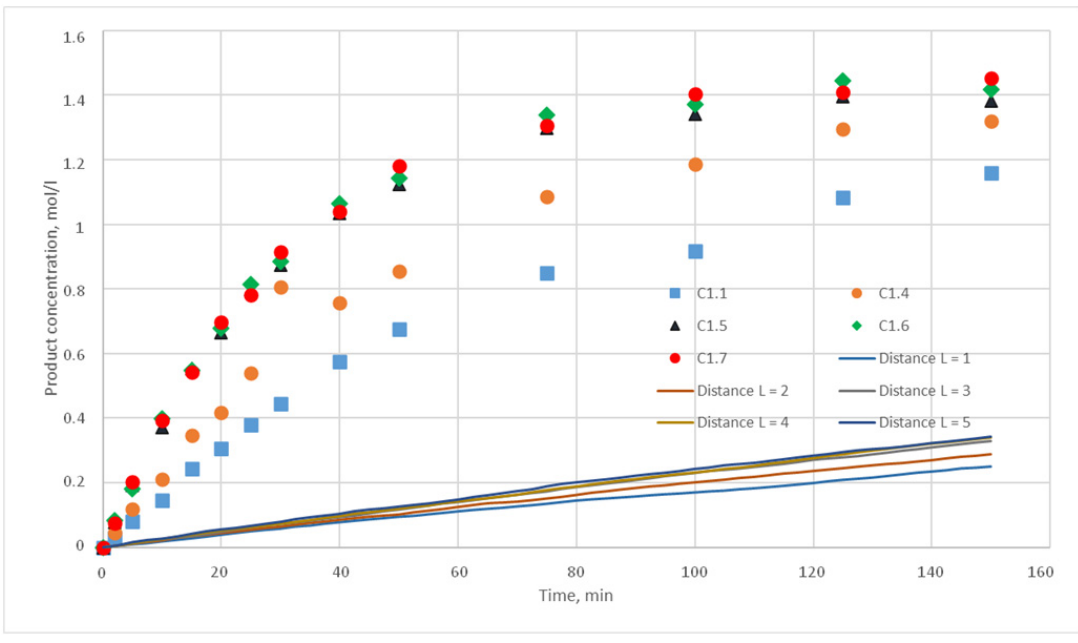
Figure 16. Calculation and experimental reaction kinetic curves. Reaction probability p = 0.001. Lines—calculation curves, points—experimental data.